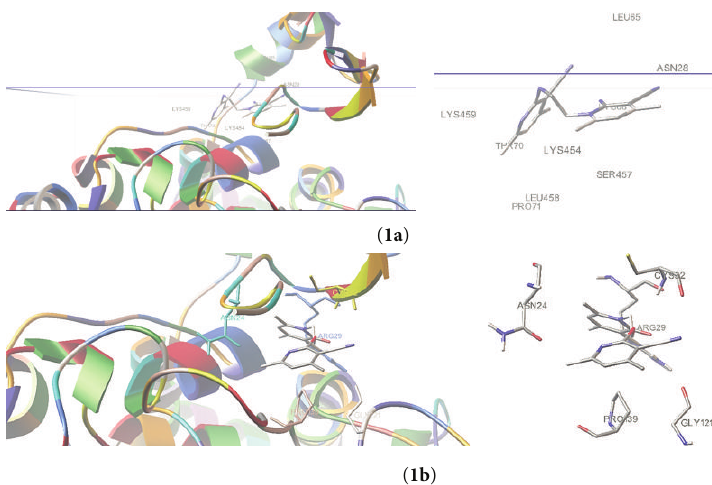
Figure 4: Docking analysis of both polymorphs.